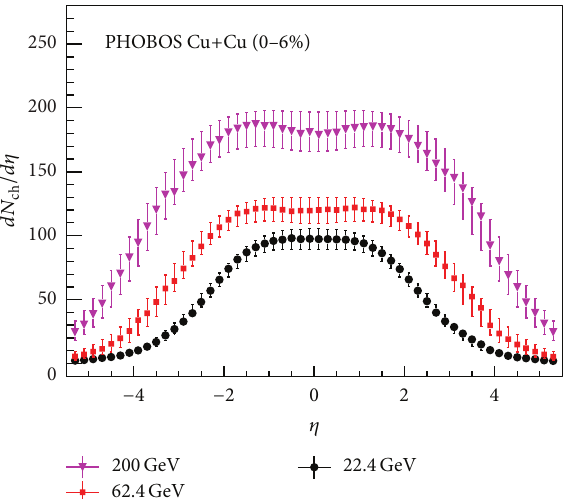
Figure 2: Charged particle pseudorapidity distributions of Cu+Cu collision systems for the most central events for different collision energies.